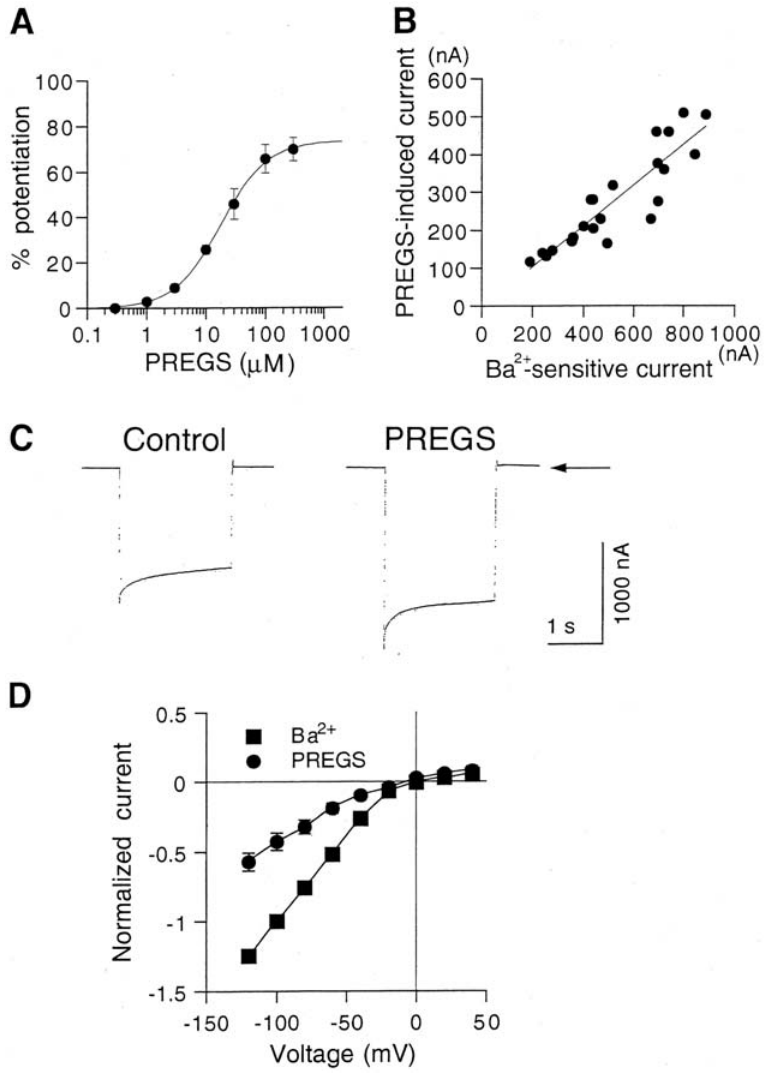
Figure 2. Characteristics of Kir2.3 channel potentiation by PREGS. (A) Concentration-dependent effect of PREGS on Kir2.3 channels. The magnitudes of Kir2.3 currents potentiated by PREGS were normalized to the 3 mM Ba 2 + -sensitive current components in Xenopus oocytes expressing Kir2.3 channels (554.0 6 79.9 nA, n =6). Data are expressed as mean 6 SEM of the percentage responses. (B) Correlation between amplitudes of current response to 30 m M PREGS and amplitudes of the 3 mM Ba 2 + -sensitive current components in oocytes expressing Kir2.3 channels. The correlation coefficient was 0.894 ( P , 0.05, n =22, regression analysis). Current responses were measured at a membrane potential of 2 70 mV in an hK solution containing 96 mM K + . (C) Representative Kir2.3 currents elicited by a voltage step to 2 100 mV for 2 s from a holding potential of 0 mV in the presence or absence of 30 m M PREGS in an oocyte injected with Kir2.3 mRNA. Arrow indicates the zero current level. (D) Current-voltage relationships of 3 mM Ba 2 + -sensitive currents and 30 m M PREGS-enhanced currents in oocytes expressing Kir2.3 channels. Current responses were normalized to the 3 mM Ba 2 + -sensitive current component measured at a membrane potential of 2 100 mV (1510.0 6 209.9 nA, n =6).